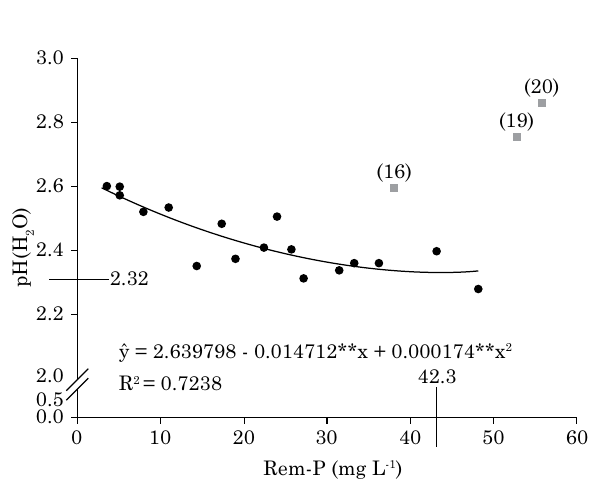
figure 3. Values of ph(h 2 o) of the extract-soil of Monocalcium phosphate in acetic acid as a variable of remaining p values (rem-p) of the soils. The three points identified for the soils ( ) were excluded from the fit. **: significant at 1 % by the t test. (│) Values of x and y that denote the minimum point.